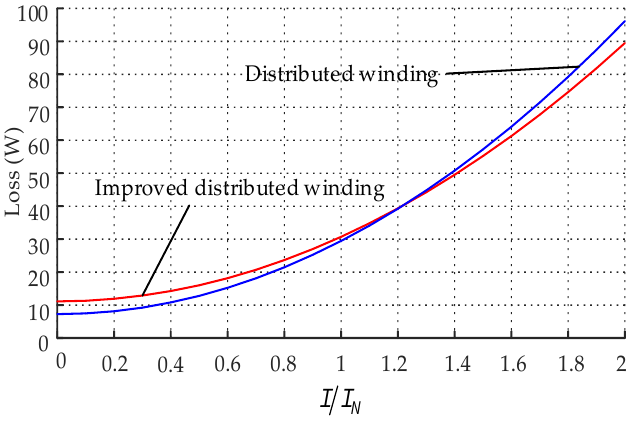
Figure 10. Curve of loss with current.